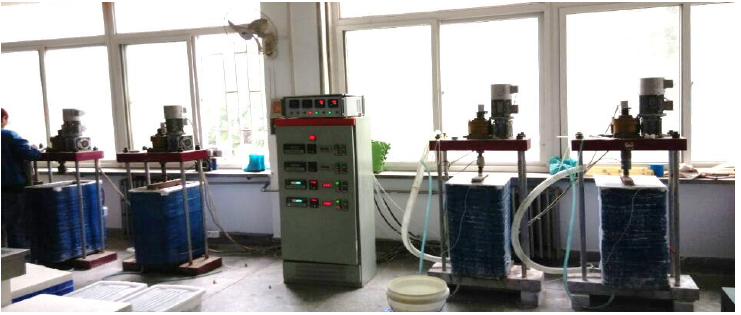
Figure 1. Test device for sulfate attack of concrete under drying–wetting cycles coupled with alternating loads.